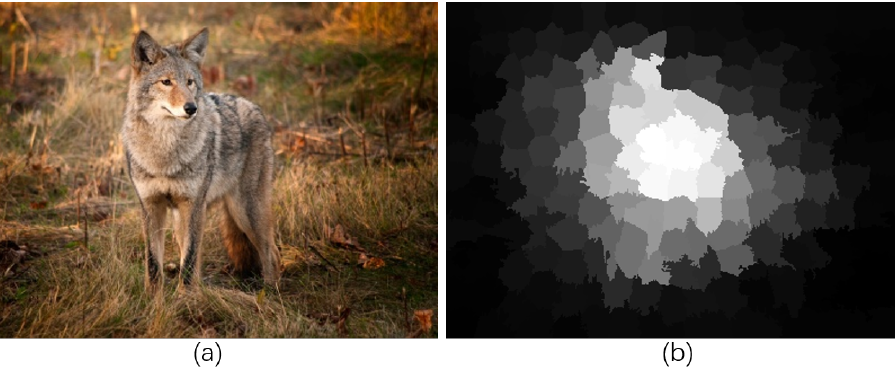
Figure 8. Failure result of our method: ( a ) input image; ( b ) saliency map of our